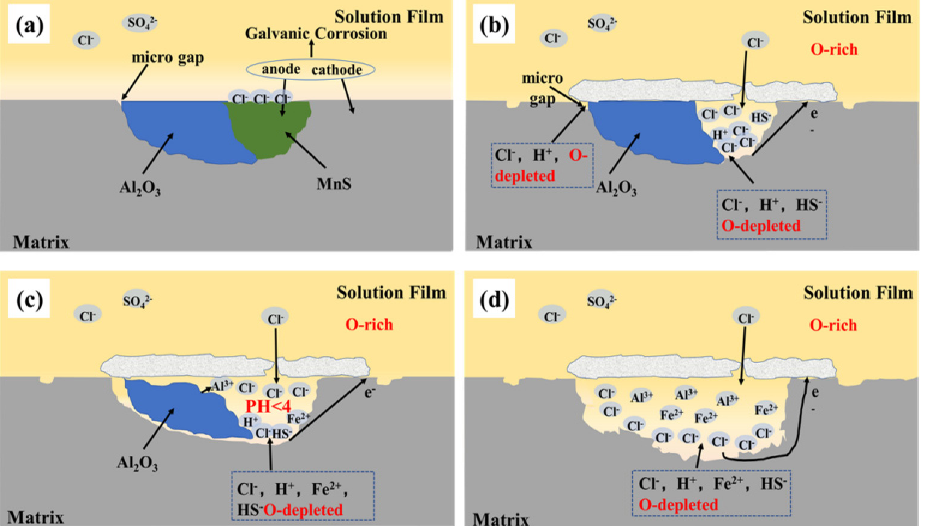
Figure 6. Schematic diagram of the process of the appearance and expansion of micro-pits caused by Al 2 O 3 -MnS inclusions. ( a ) Trigger of localized corrosion around inclusion, ( b ) dissolution of MnS portion, ( c ) dissolution of Al 2 O 3 , and ( d ) stable pits formed with inclusion